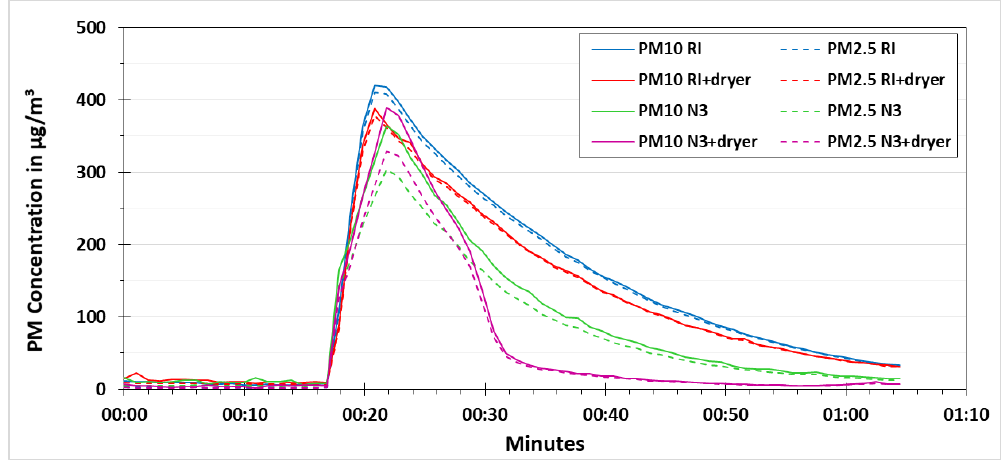
Figure 12. PM concentration comparison for testing the low-cost dryer at an applied voltage of 9 V.